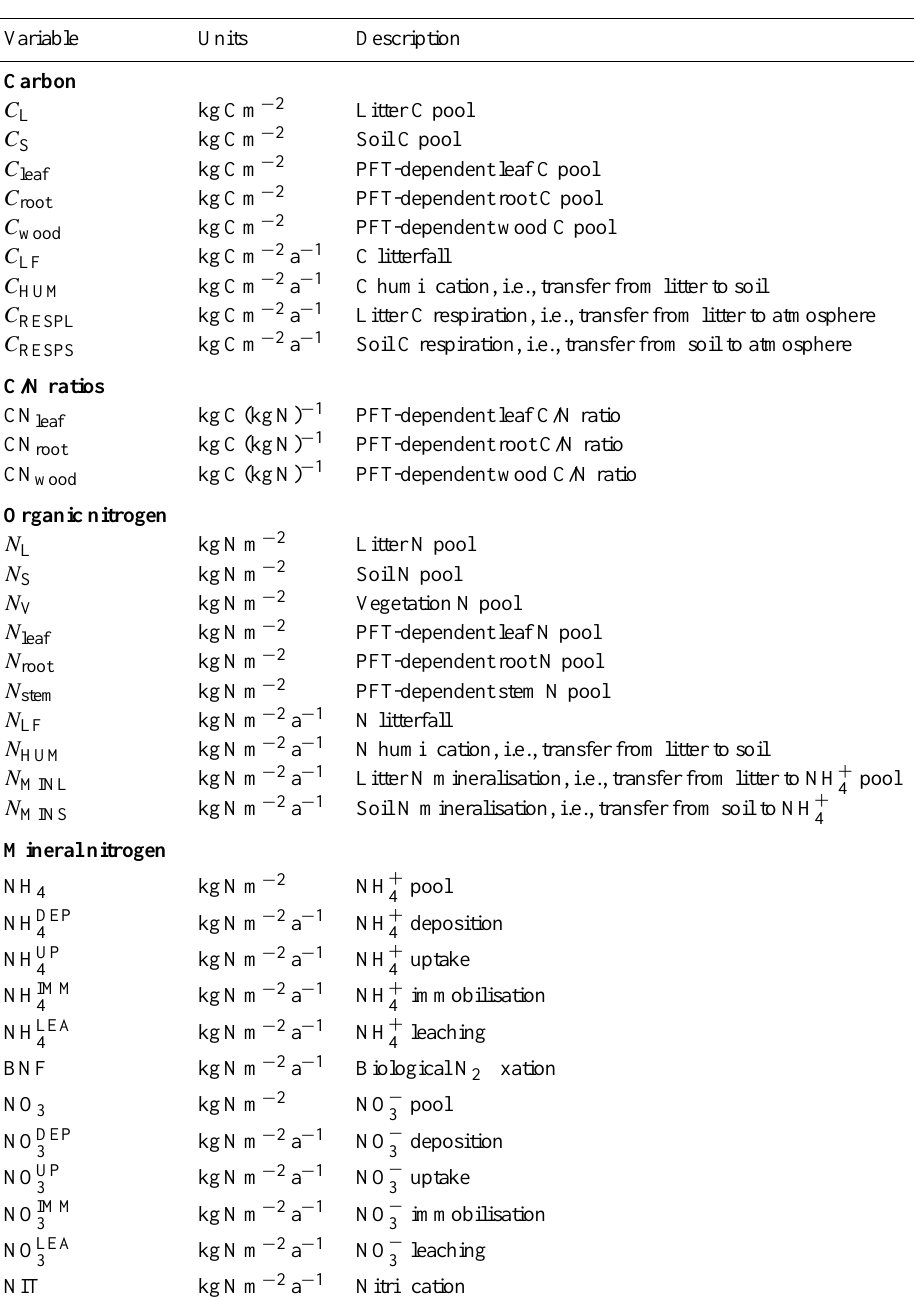
Table 1. Pools and fluxes in the UVic CN-coupled